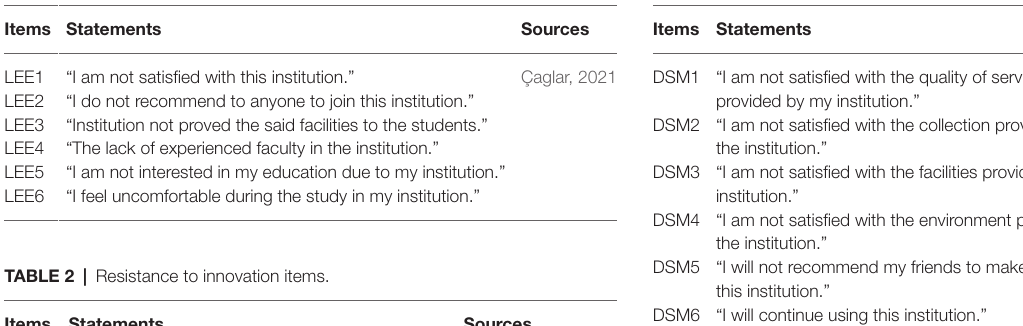
TABLE 1 | Lack emotional experience